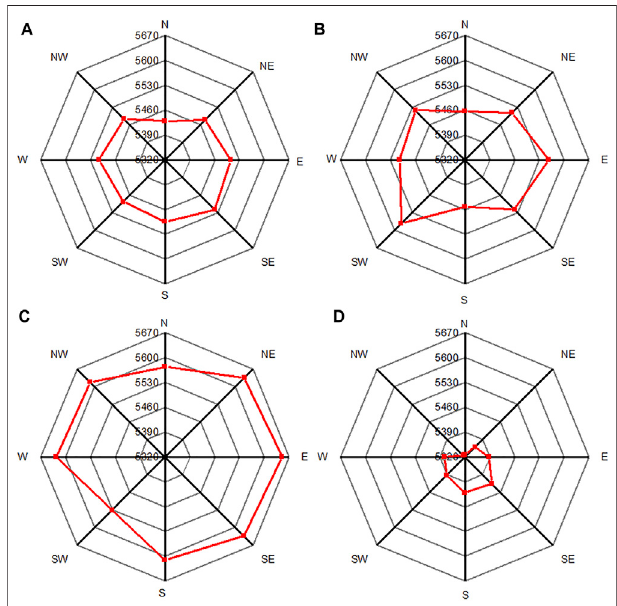
FIGURE5| Cirqueaspectsfor (A) theentiredataset, (B) thewestern( n = 562), (C) central ( n = 454) and (D) eastern ( n = 636) parts of the Gangdise Mountains.